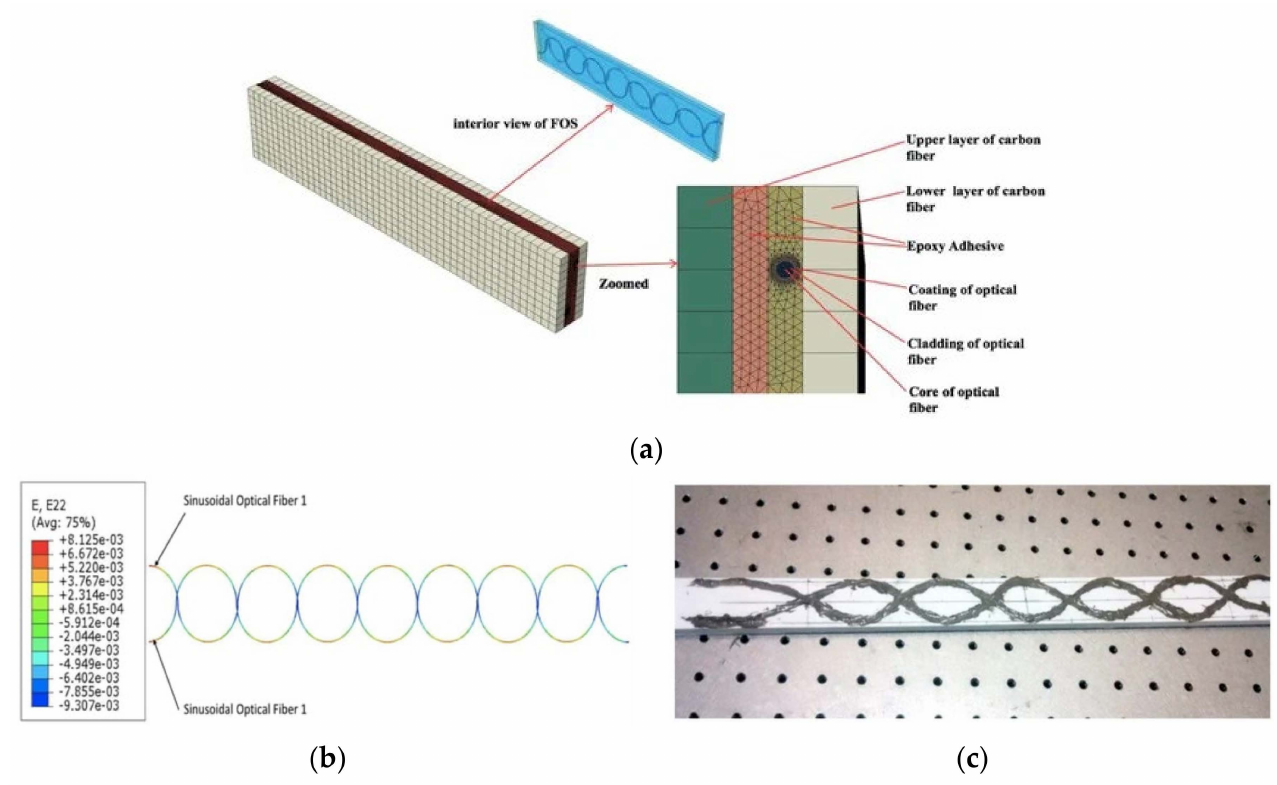
Figure 4. ( a ) Loads and boundary conditions properties used for model having dual-sinusoidal optical fiber placement. ( b ) Dual-sinusoidal FOSs’ placement embedded on a glass composite specimen. ( c ) Strain measurements showing dual-sinusoidal FOSs placement (placement in dual-sinusoidal mode, in phase opposition, provides coverage complementary to that of a single sinusoidal